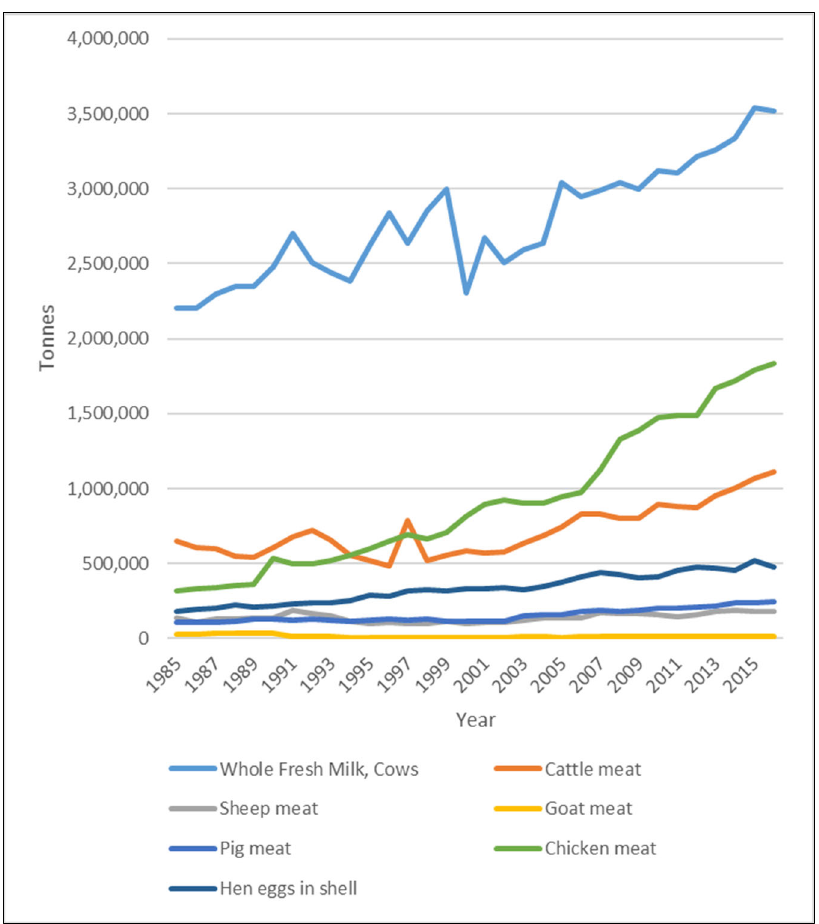
Figure 2. Production in Tonnes of Livestock-Derived Food